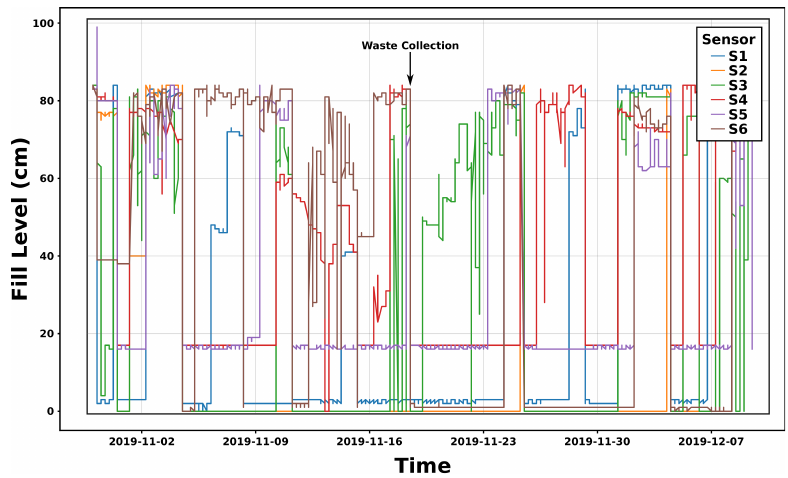
Figure 26. Raw data on a site composed by 6